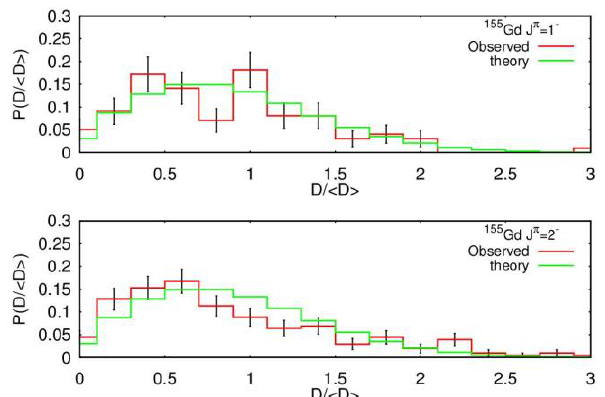
Fig. 6. Wigner distribution (theory) of the resonances spacing in the energy 0 eV to 500 eV for 155 Gd.